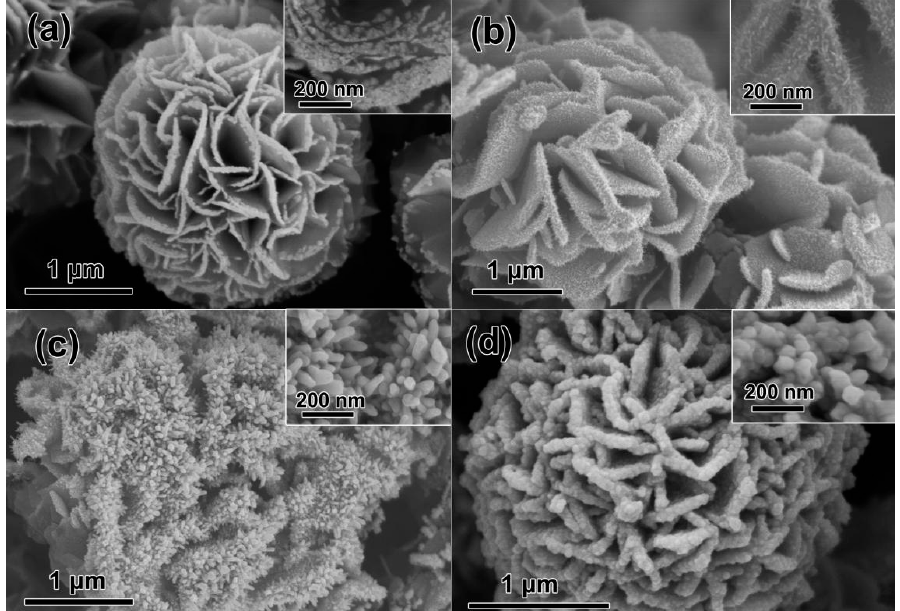
Figure 5. Morphological evaluations of the 3D hierarchical Au/CuS nanostructures obtained by adding different amounts of HAuCl 4 into 15 mL of Cu 2 S microflower suspension. ( a ) 0.2 mL, ( b ) 1 mL, ( c ) 10 mL, and ( d ) 15 mL. Insets are the corresponding magnified images.